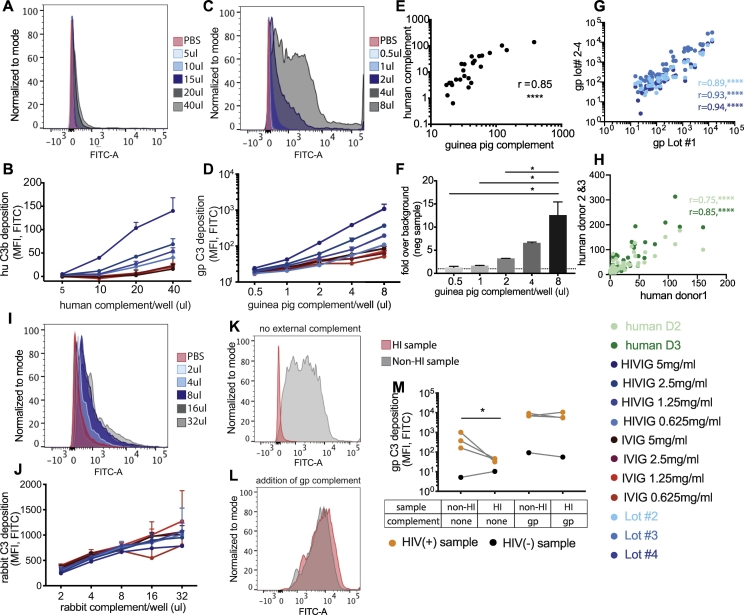
Comparison of complement from different species and optimization of the complement incubation step. The ADCD assay was run using human (A, B, and H), guinea pig (C–G, K–M), or rabbit (I–J) complement, together with HIV gp120 as antigen and plasma or purified IgG from HIV-positive and HIV-negative subjects. A different, species-specific detection antibody was used for each source of complement. A, C, I: The histograms indicate results for the 5 mg/ml HIVIG sample using the indicated amounts of complement per well or a PBS control. B, D, J: Line graphs show C3 deposition results over a range of complement amounts, for the indicated HIVIG and IVIG concentrations. Point and error bars indicate mean ± SD of technical triplicates. E: C3 deposition results using 20 μl/well human complement or 4 μl/well guinea pig complement were correlated. Dots represent data for each HIVIG and IVIG concentration tested in panels B and D. F: Bar graph shows the calculated signal (C3 deposition using 5 mg/ml HIVIG) to noise (C3 deposition using 5 mg/ml IVIG) ratios for the indicated amounts of added guinea pig complement. Bars represent the mean ± SD of technical triplicates. The dotted line indicates a signal-to-noise ratio of 1. One way ANOVA was performed on all groups, *p < 0.0332. G: Correlation plot shows the pairwise correlation between four guinea pig complement lot numbers across HIV positive and negative samples. H: Correlation plot depicts comparison of three human plasma donors against four concentrations of HIVIG and IVIG over different amounts of added human plasma as complement source (same set up as in 4B). All correlations were performed as two-tailed Spearman correlations. ****, p < 0.0001 K and L: Histograms depict complement deposition results for an HIV-positive plasma sample with or without prior heatinactivation of the sample, either in the absence (K) or presence (L) of 4 μl/well exogenous guinea pig complement. M: C3 deposition results are shown for HIV-positive and HIV-negative plasma samples tested with or without prior heat-inactivation of the samples, and either with or without 4 μl/well exogenous guinea pig complement. Statistics were performed using a paired t-test. *p > 0.0332. Differences between HI or non-HI sample were not statistically significant by paired t-test.